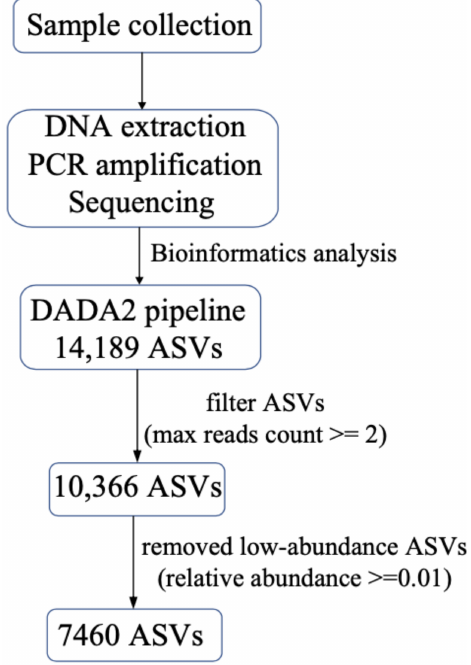
Figure 2. A flowchart describing the bioinformatics processing